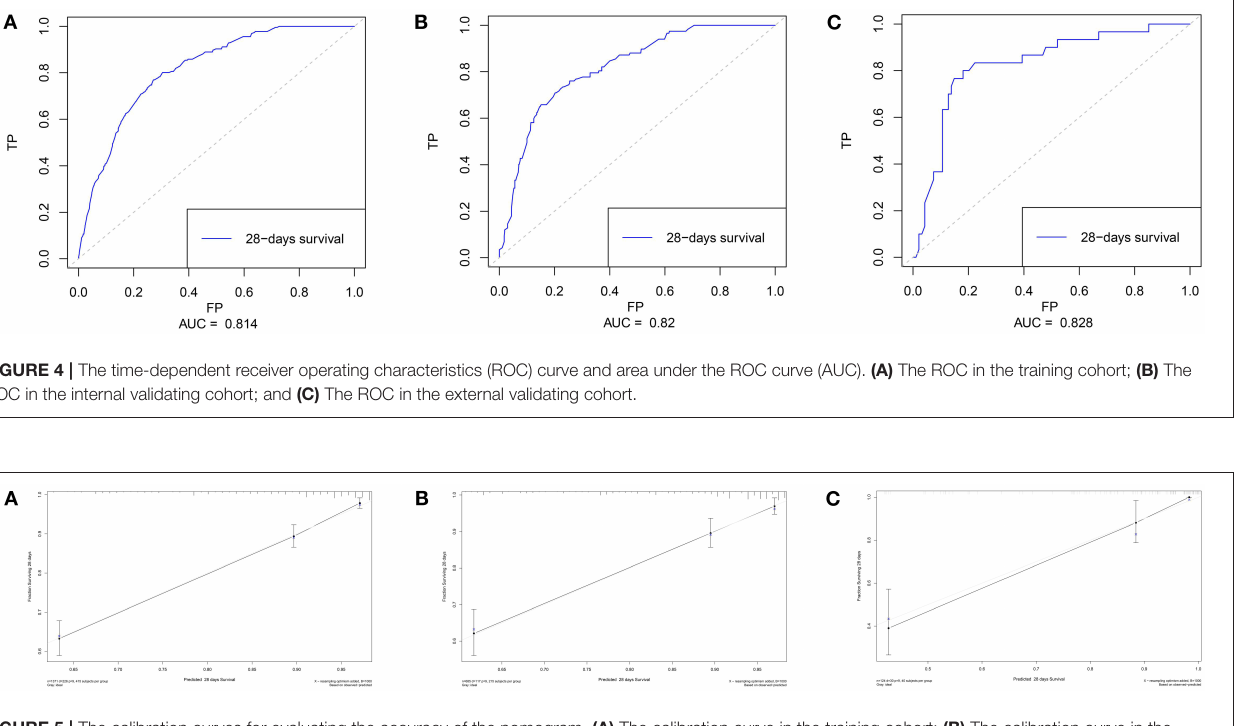
FIGURE 5 | The calibration curves for evaluating the accuracy of the nomogram. (A) The calibration curve in the training cohort; (B) The calibration curve in the internal validation cohort derived from the 1,000 resampling bootstrap analysis; and (C) The calibration curve in the external validation